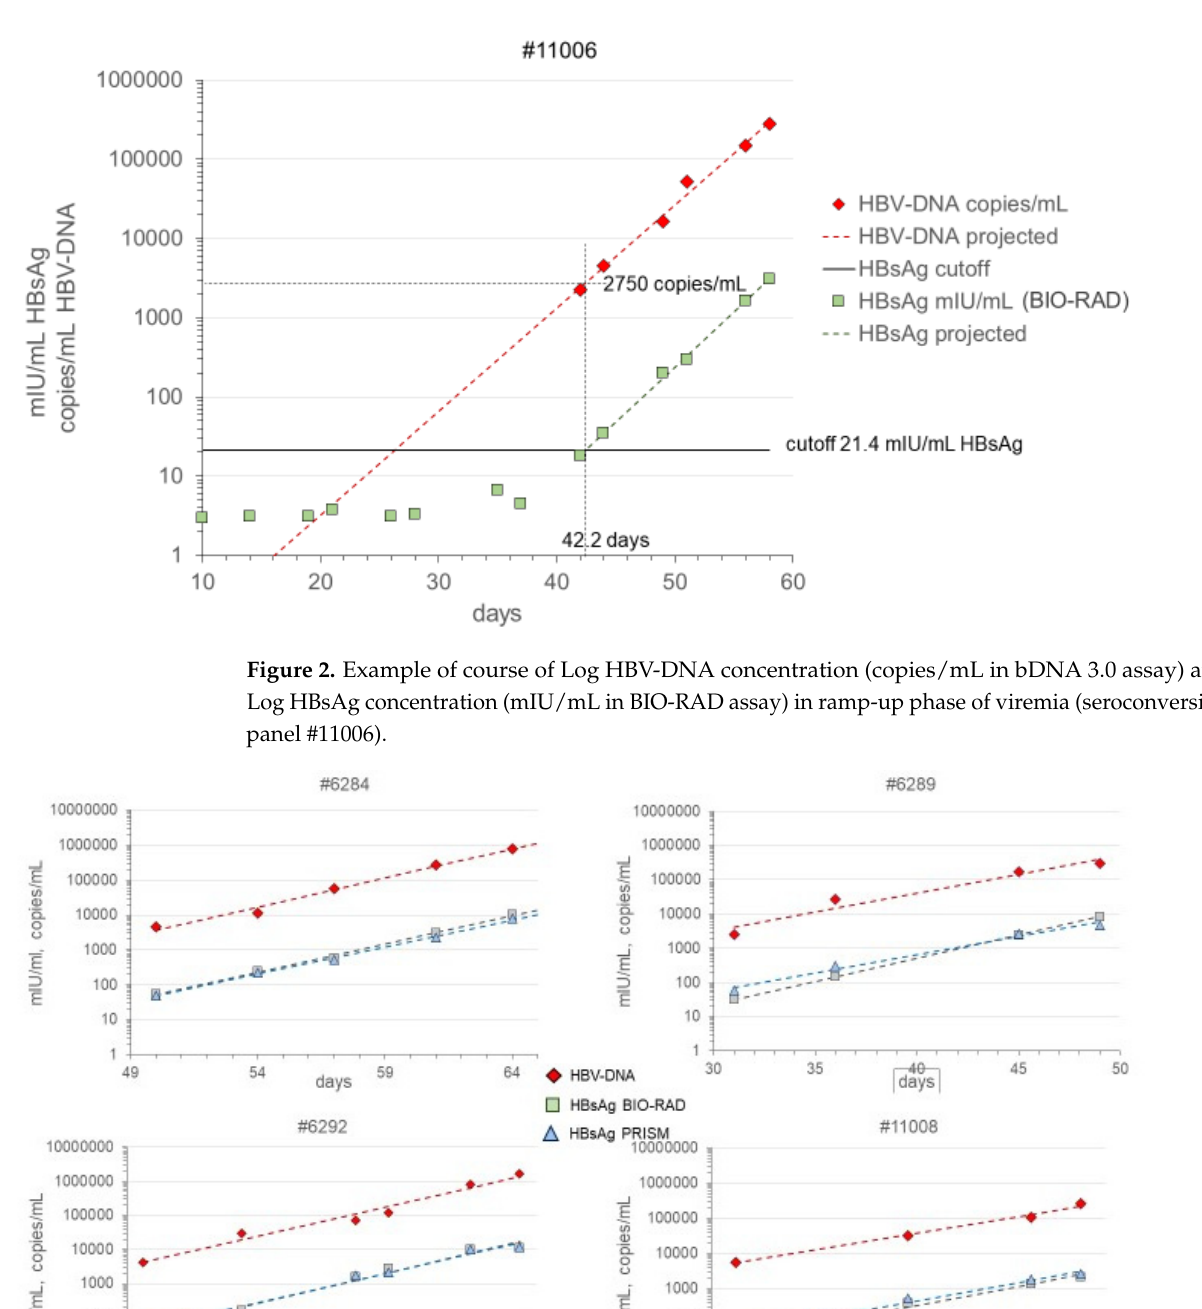
Figure 1. Calibration curves of twofold WHO 00/588 HBsAg standard dilutions tested twice in du ‐ plicate in HBsAg PRISM assay showing better linearization of the regression line until cutoff level when plotting Log IU/mL against Logit S/CO ratio ( right graph) than Log IU/mL against Log S/CO ( left graph).